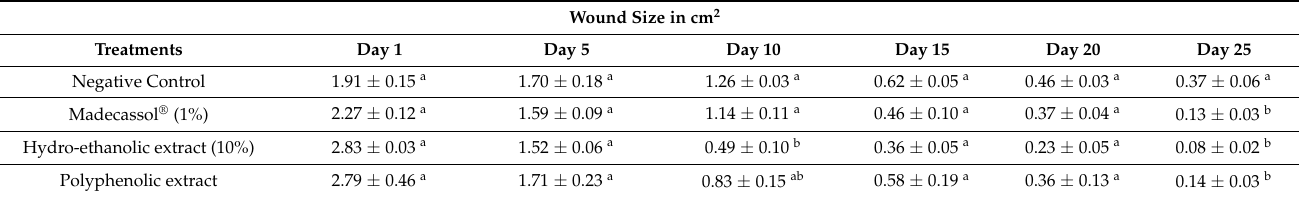
Table 8. Wound size (cm 2 ) of the hydro-ethanolic and polyphenols extracts of P. sativum Hoffm.